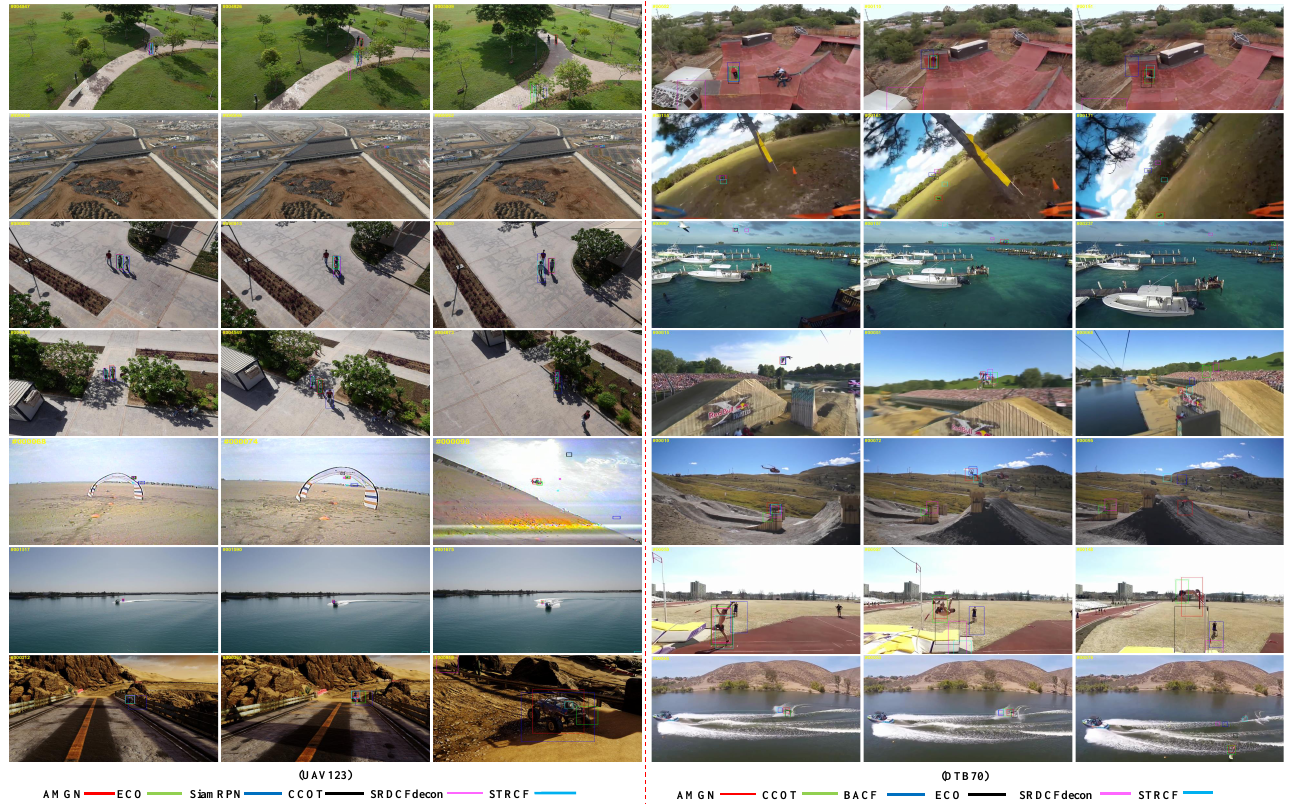
Figure 13. Qualitative results of the comparison tracker on challenging sequences from UAV123 and